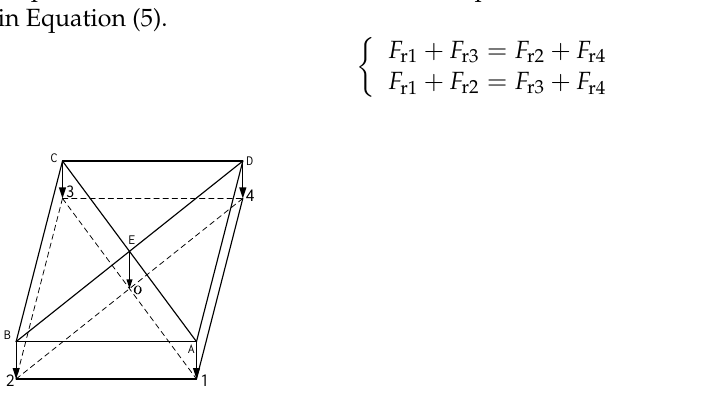
Figure 6. Schematic diagram of statically indeterminate workbench.